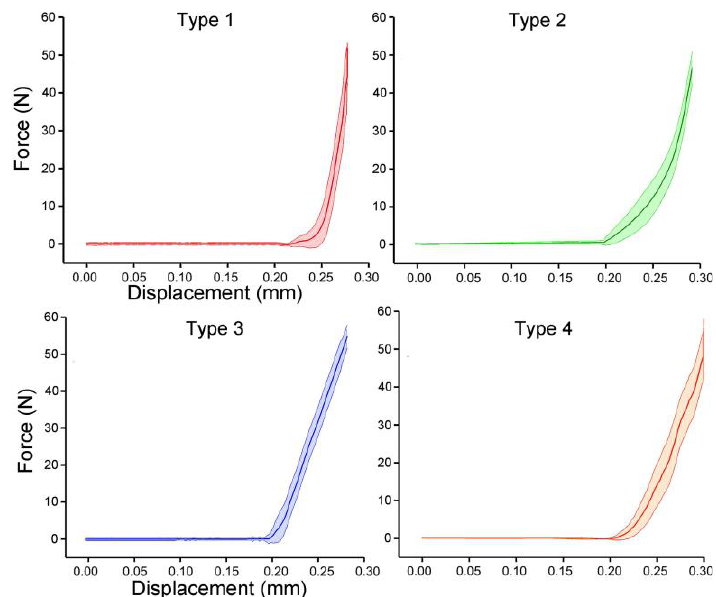
Figure 6. Force-displacement curves of the four bionic tubes. Mean ± standard deviations were depicted, n = 10.